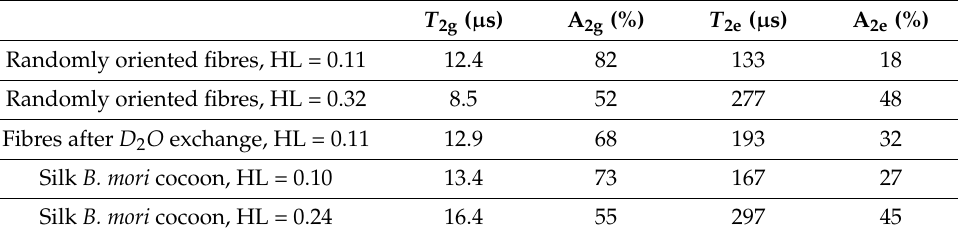
Table 1. NMR relaxation times (T 2 ) of protons in randomly oriented silk fibres and in Bombyx mori cocoon. Effect of D 2 O on exchangeable protons in silk fibres B. mori . T 2g ( µ s) A 2g (%) T 2e ( µ s) A 2e (%) Randomly oriented fibres, HL = 0.11 12.4 82 133 18 Randomly oriented fibres, HL = 0.32 8.5 52 277 48 Fibres after D 2 O exchange, HL = 0.11 12.9 68 193 32 13.4 73 167 27 16.4 55 297